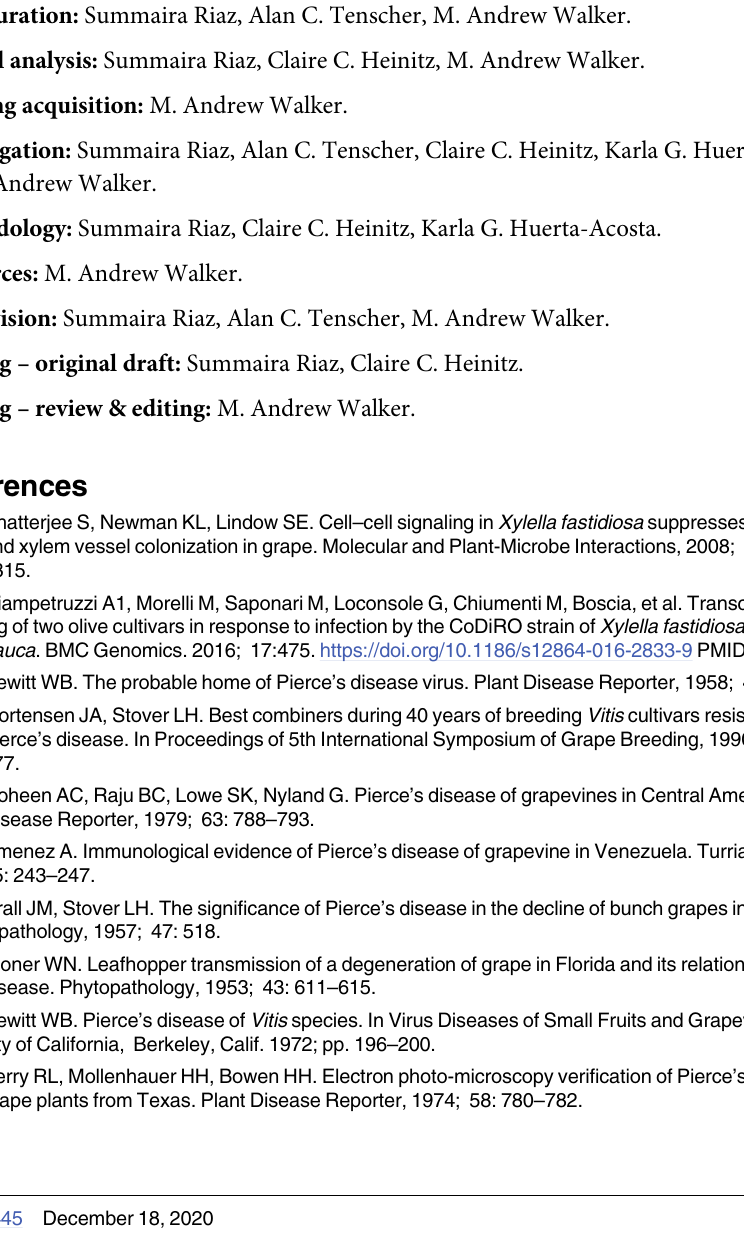
S6 Table. Population assignment to two groups and Q-values were determined with the STRUCTURE program. Hierarchal STRUCTURE analysis on each group clearly divided each group into clusters of distinct species. K1 cluster divided into four groups and K2 cluster into three distinct groups. S7 Table. Summary of F statistics and gene flow for the 20 loci over all populations within two